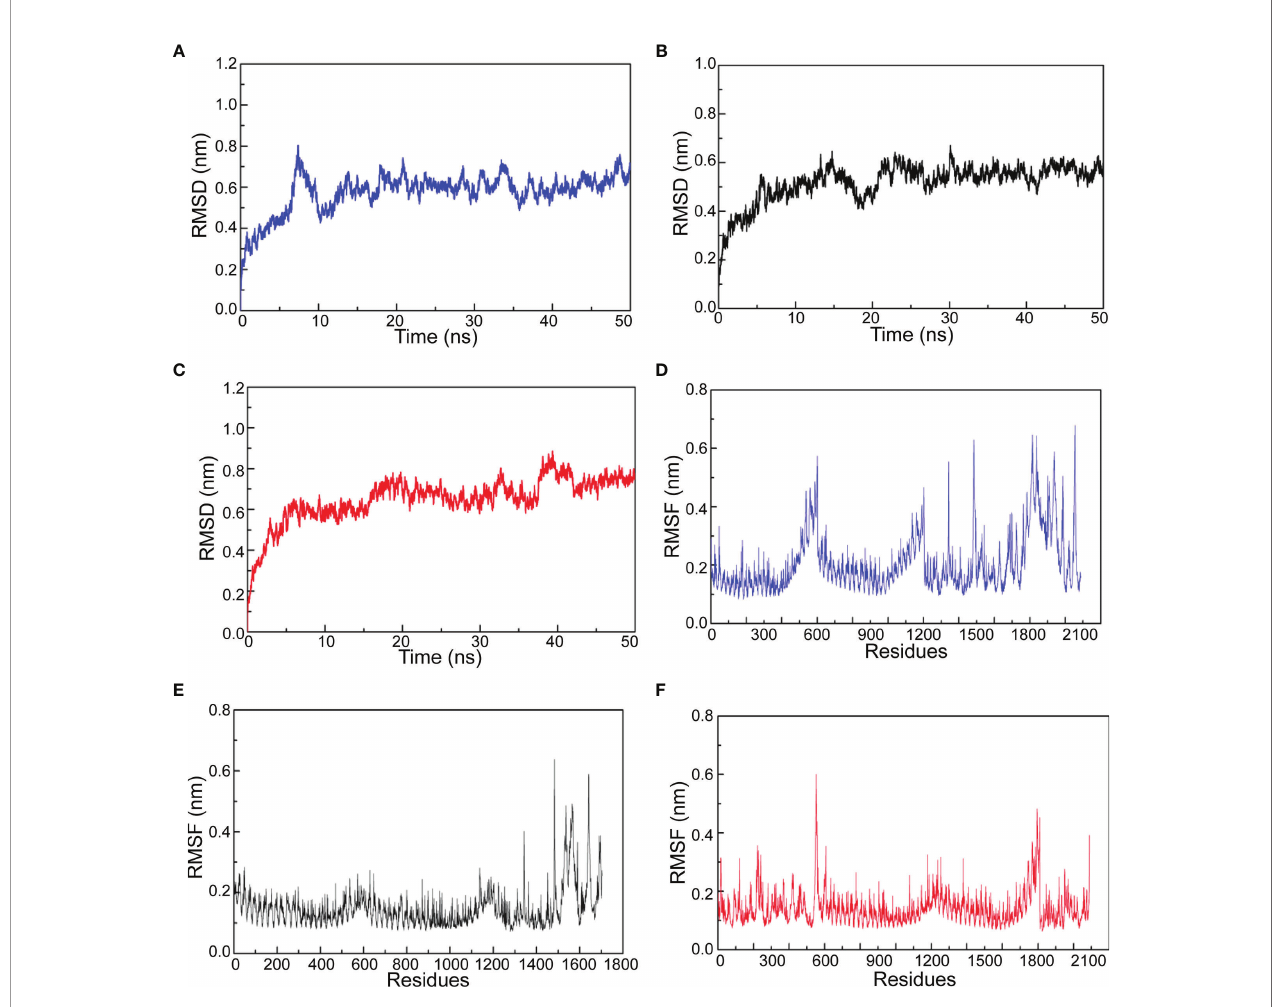
FIGURE 7 | The results of molecular dynamics simulation. (A) Amino acid permease and TLR4/MD2 complex RMSD. (B) Amastin-like protein and TLD4/MD2 complex RMSD. (C) Hypothetical protein (XP_003865405.1) and TLR4/MD2 complex RMSD. (D) Amino acid permease and TLR4/MD2 complex RMSF. (E) Amastin-like protein and TLD4/MD2 complex RMSF. (F) Hypothetical protein (XP_003865405.1) and TLR4/MD2 complex